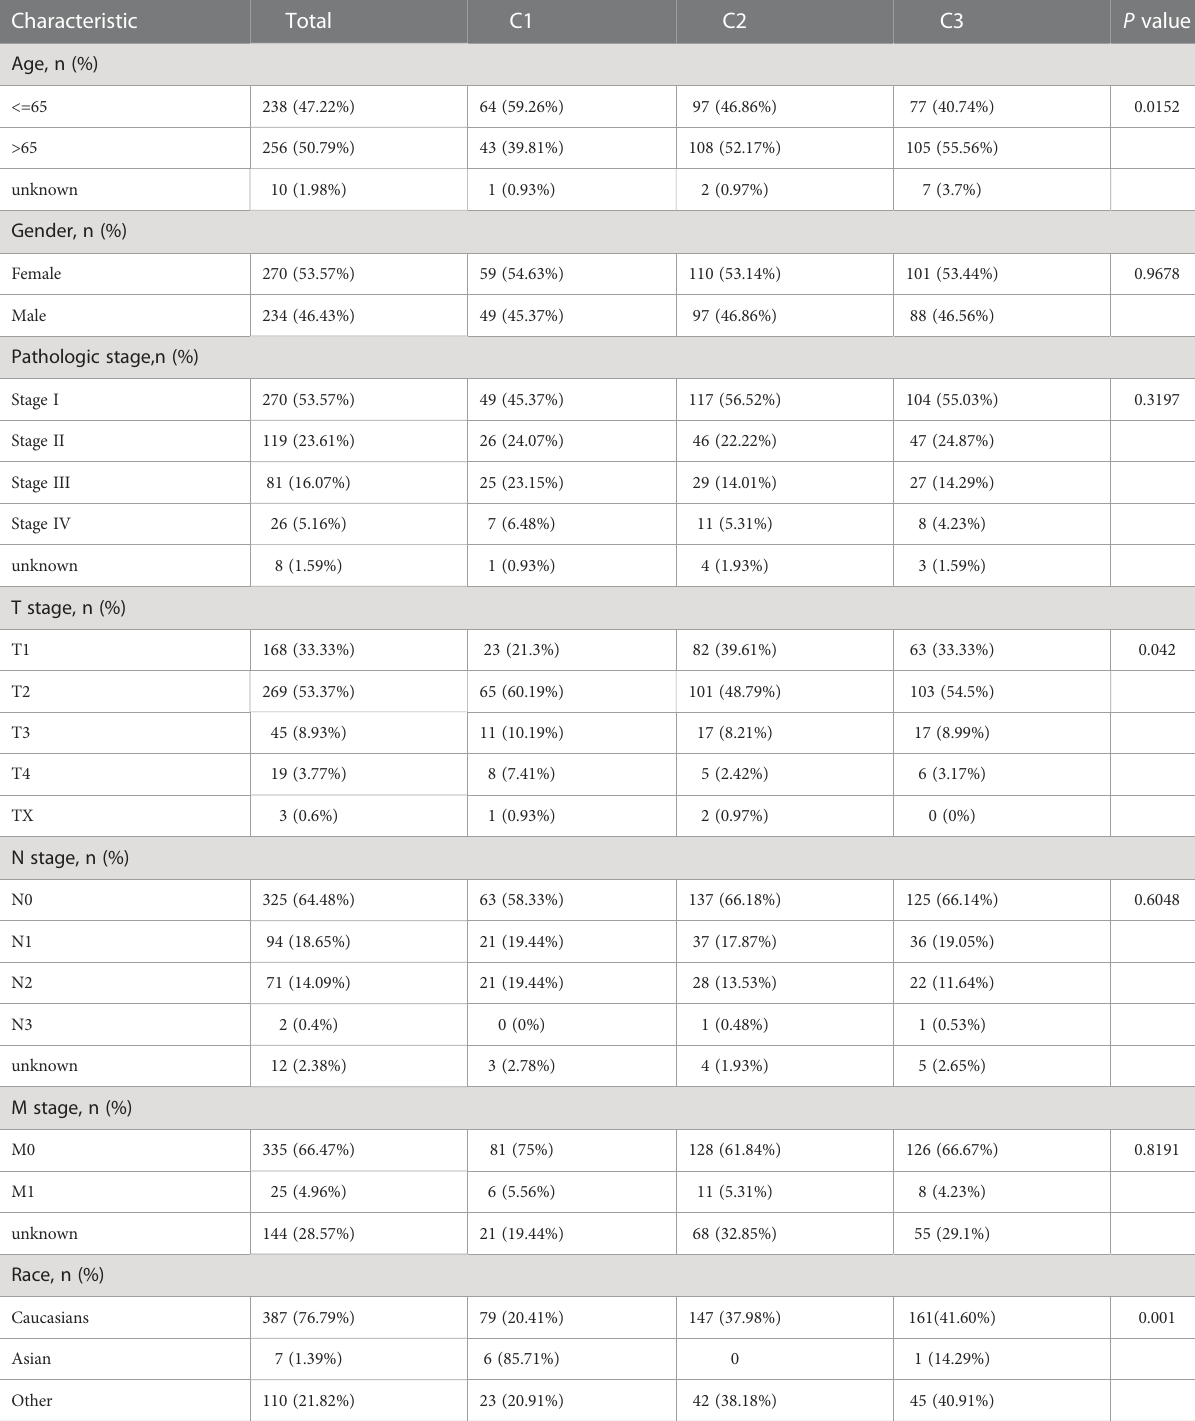
TABLE 1 The relevance among subtypes and clinical data